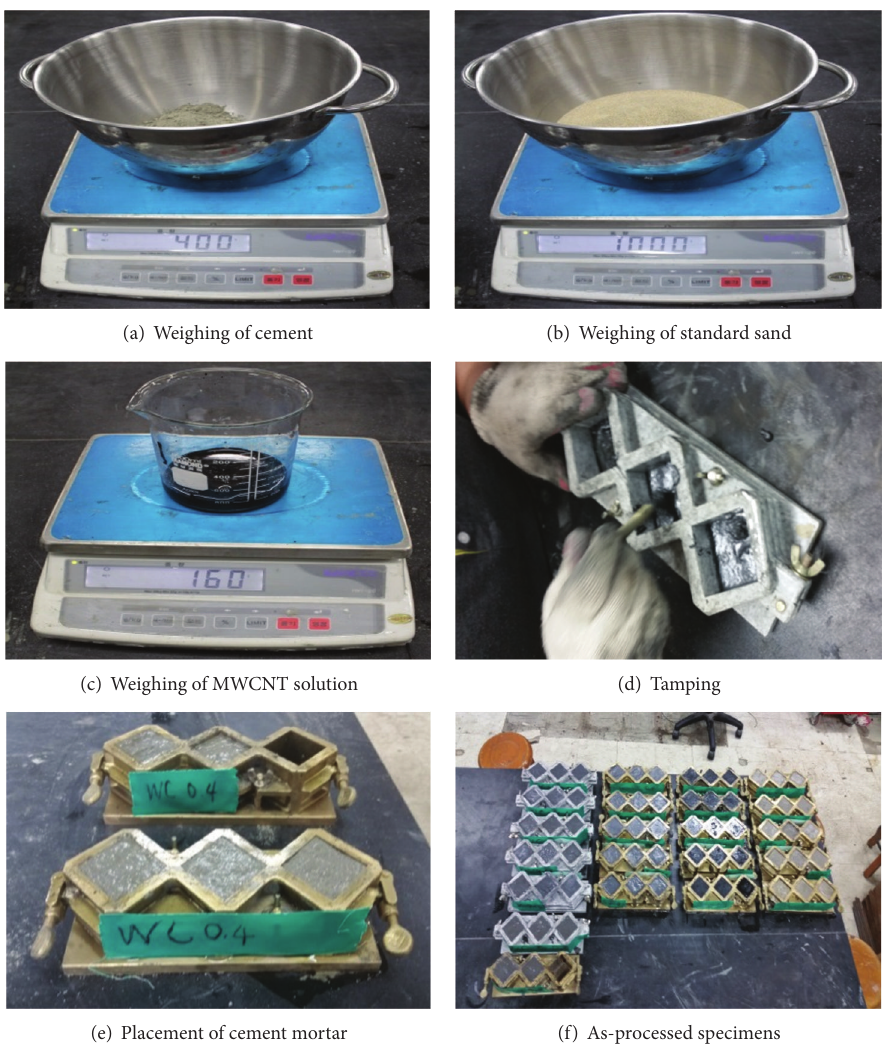
Figure 2: Specimen fabrication